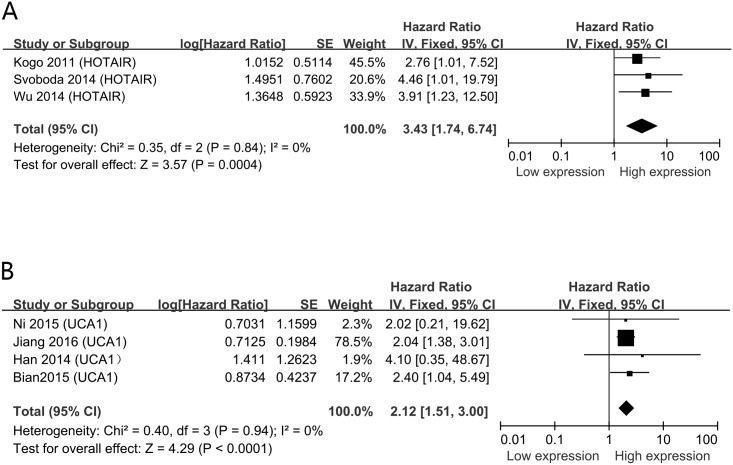
Forest plots of studies evaluating hazard ratios of up-regulated lncRNAs and the overall survival of CRC patients.A. HOTAIR; B. UCA1.